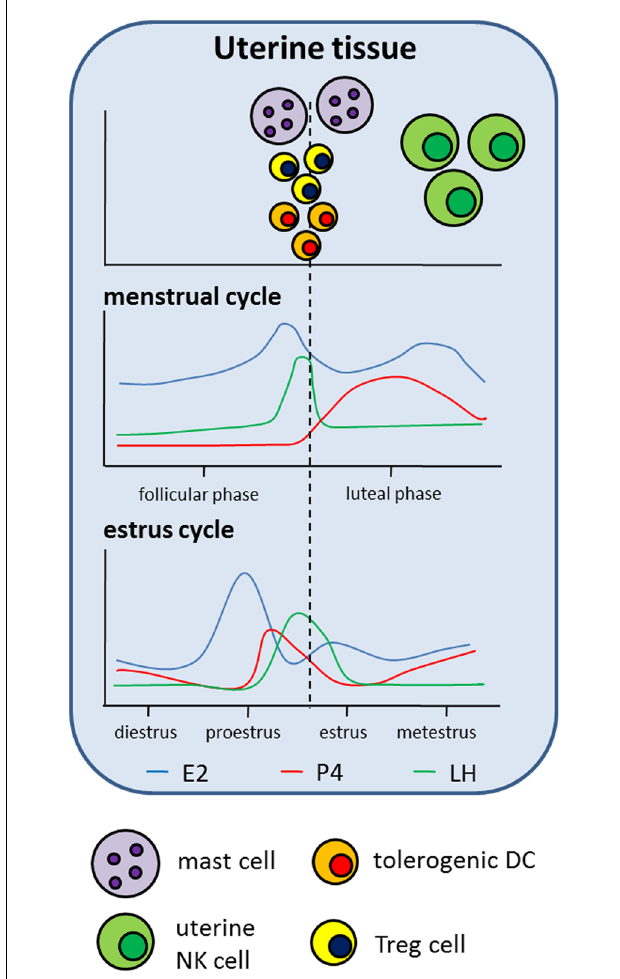
FIGURE 2 | Hypothetical scenario presenting the influence of hormonal changes taking place during the reproductive cycle on the distribution of innate and adaptive immune cell populations in the uterus .The upper part of the scenario displays the accumulation of different immune cell populations in uterine tissue correlated with the different phases of the human menstrual cycle and the murine estrus cycle.The lower part of the scenario displays hormonal changes taking place during the reproductive cycles, both in humans and